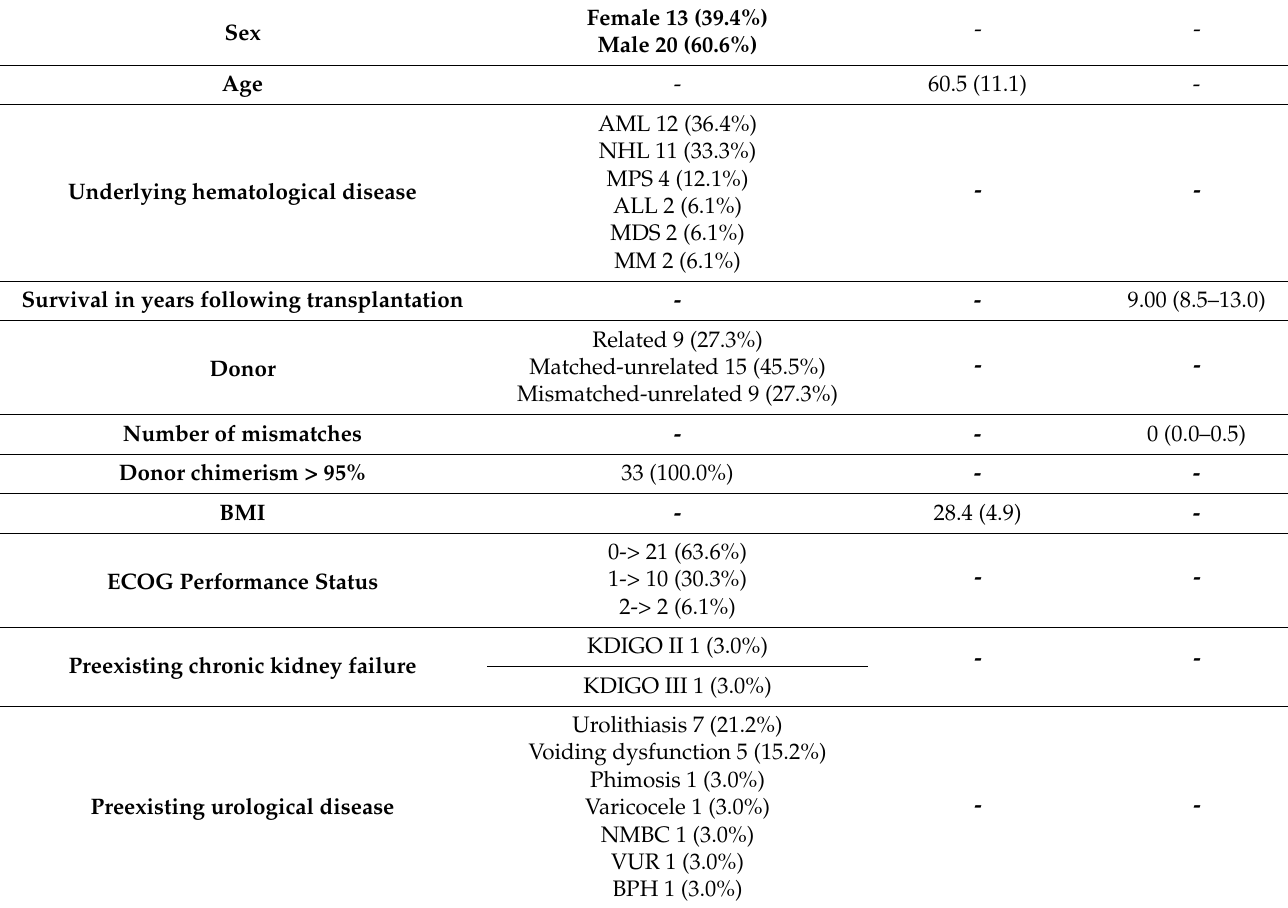
Table 1. Demographic characterization of the study population (n =